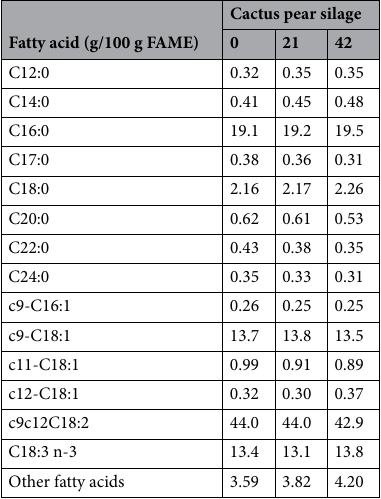
Fatty acid (g/100 g